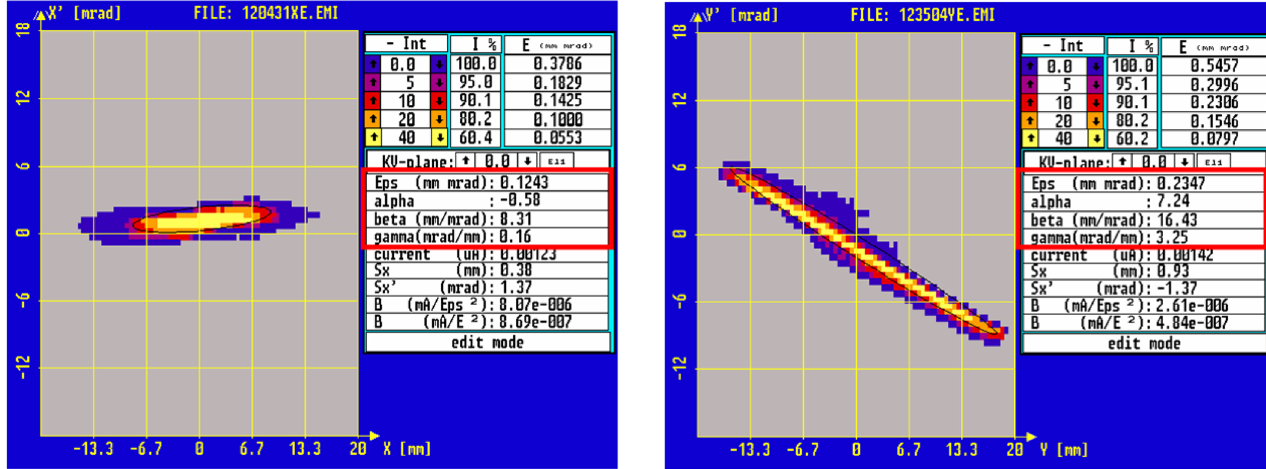
4. (Color) Horizontal (left) and vertical (right) phase space distribution measured in front of the DTL for a 7.1 mA beam of 40 Ar 10 þ . Normalized rms-Twiss parameters corresponding to 100% of the total intensity are highlighted in